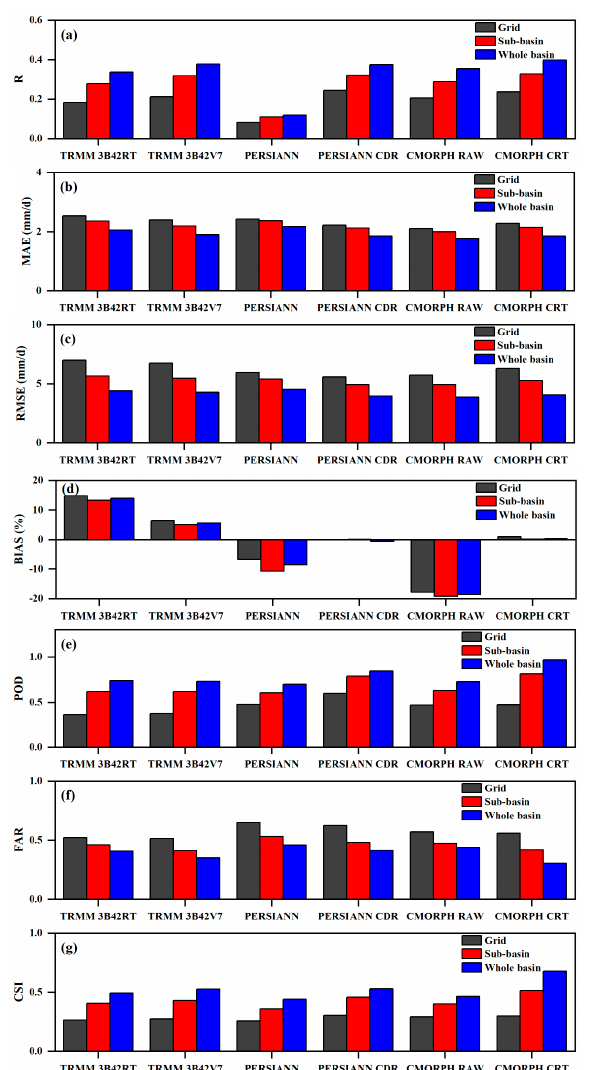
Figure 2. Statistical results of ( a ) R, ( b ) MAE, ( c ) RMSE, ( d ) BIAS, ( e ) POD, ( f ) FAR and ( g ) CSI of the six SPPs for daily precipitation at di ff erent spatial